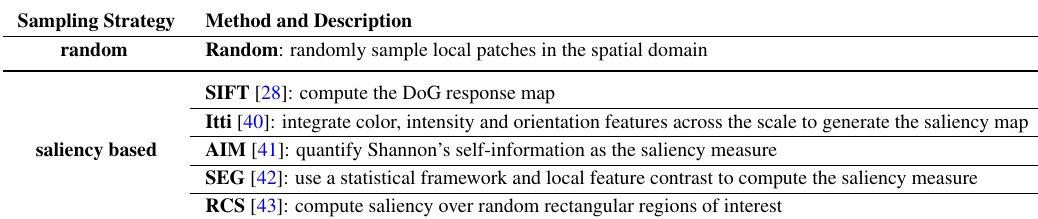
Table 1. Different sampling strategies investigated in this